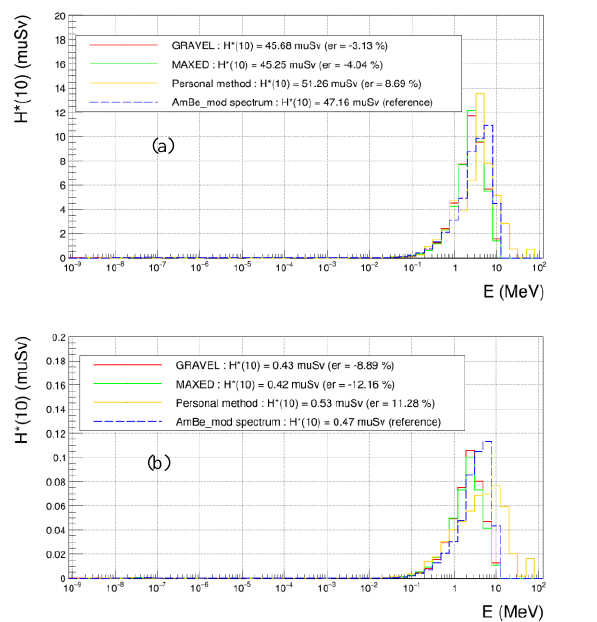
Fig. 10. Unfolding results (µSv), as function of energy (MeV), with a moderated 252 Cf guess spectrum. (a), with high statistics (Φ = 1.41×10 5 cm -2 ) and a moderated Am/Be source. (b), with low statistics (Φ = 1.41×10 3 cm -2 ) and a moderated Am/Be